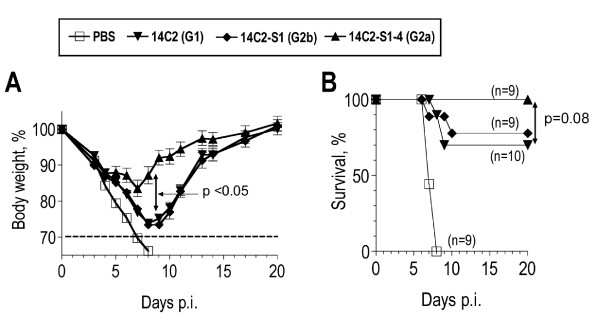
Role of heavy chain isotype in protection. Naive BALB/c mice were injected i.p. with 10 μg mAb 14C2 of G1 (triangles pointing down), G2b (diamonds) or G2a (triangles pointing up) isotype. The control group (open squares) received PBS i.p. One day later, mice were exposed to a total respiratory tract challenge with PR8 (4 LD50 in 50 μl) and monitored for weight loss. Pooled data from two independent experiments are shown, each performed with 4–5 mice/group. A. Symbols show mean % body weight and SEM (relative to day 0) of 9–10 mice/group. Differences between treatment groups were tested for statistical significance at individual days. Mice treated with G2a showed significantly (p < 0,05, ANOVA) less weight loss than those treated with G1 or G2b at days 6 to 13 p.i. B. Survival. Death was defined as >30% weight loss, at which stage mice were euthanized. Differences between survival curves were tested for statistical significance by log rank test.